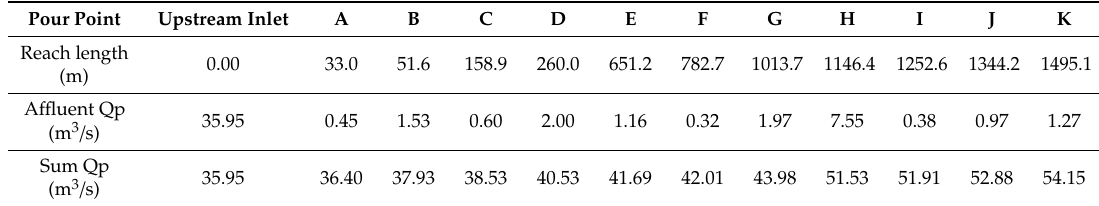
Table 1. Estimated flow data for use in the hydraulic model of the Couros river reach, in the Historic City Centre of Guimar ã